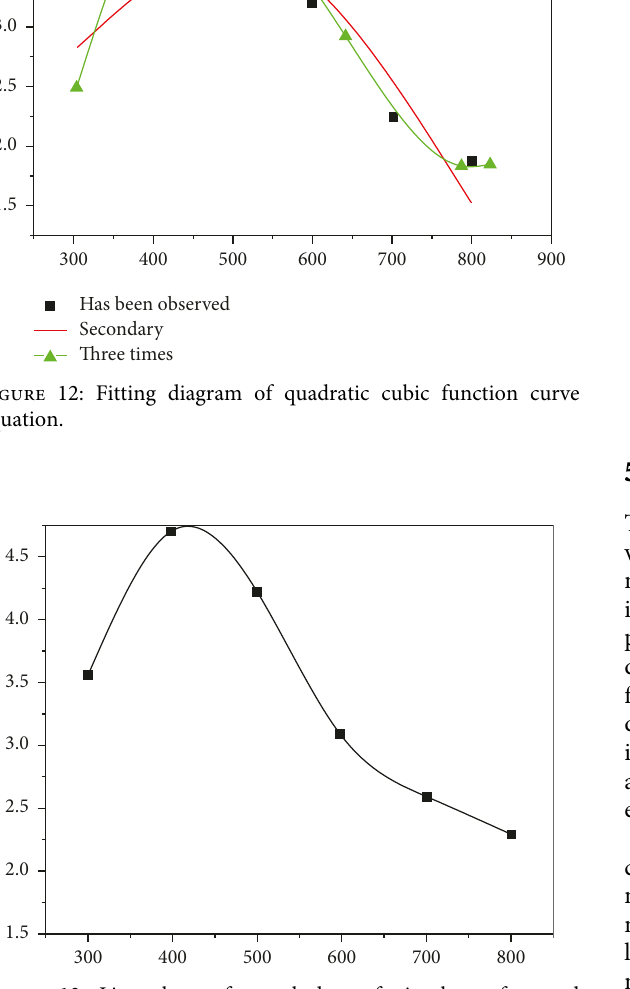
Figure 13: Line chart of actual data of visual comfort and brightness.